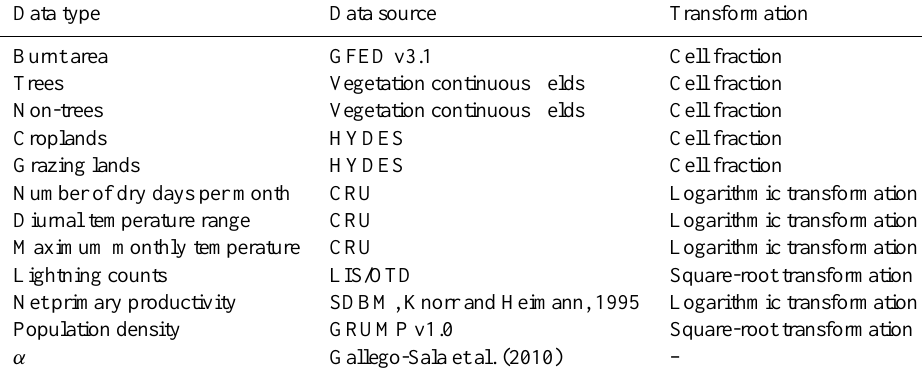
Table 1. Sources of